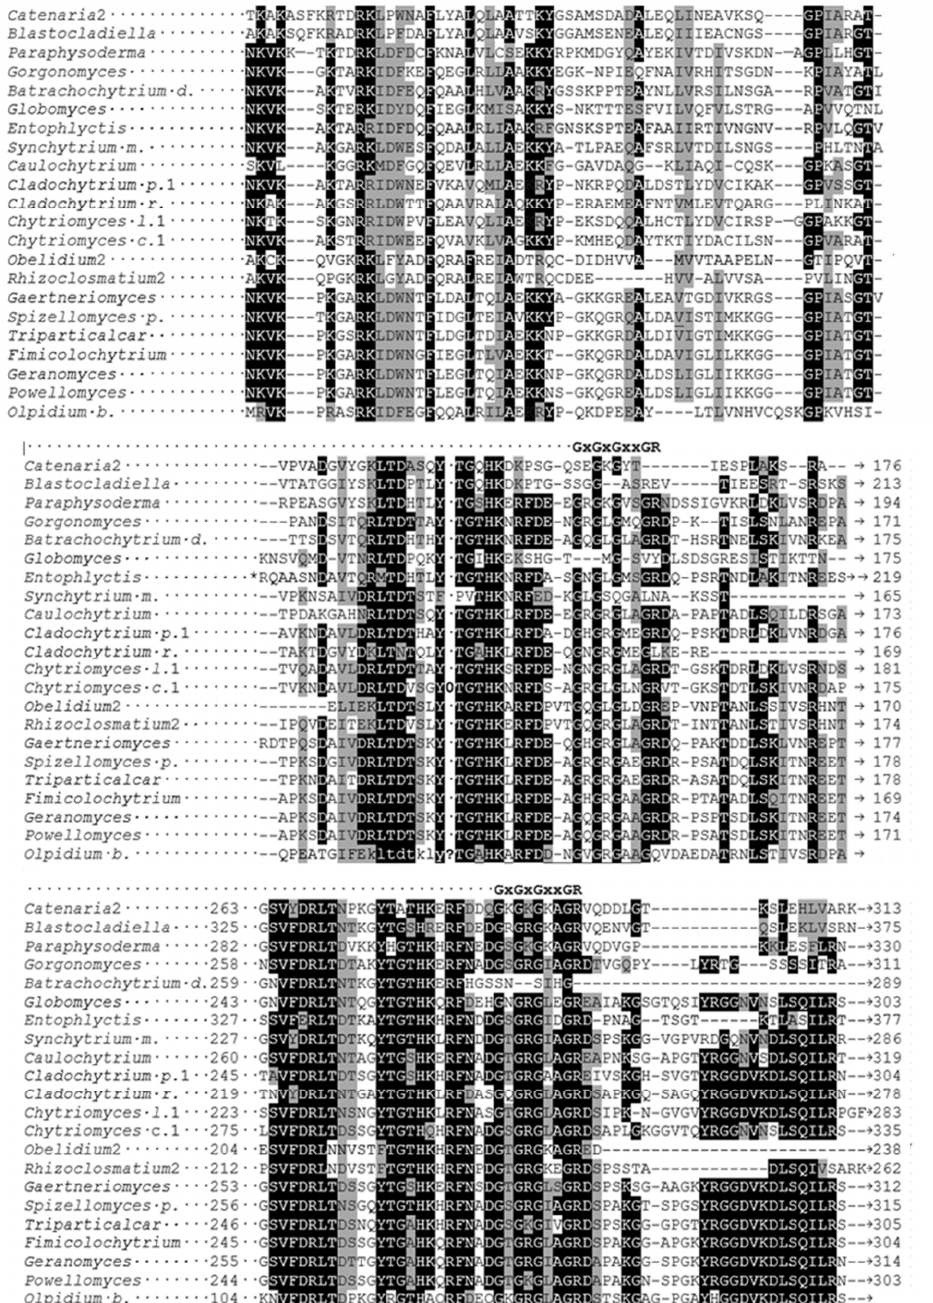
Figure 4. Multiple alignment (manually refined) of the p25alpha domains of fungal-type TPPPs by Clustal Omega [20]. The N-termini (amino acids before the p25alpha domain) and the interdomain parts are not included in the alignment. Amino acids that are identical and biochemically similar in at least two thirds of the proteins are labeled by black and grey background, respectively. The “Rossman-like” sequences, GXGXGXXGR, are also shown. The positions of a phase 1 intron of some proteins and that of a phase 0 intron of Chytriomyces confervae TPX65513 protein are marked by number 1 and 0, respectively. Asterisk (*) indicates that 39 amino acids of Enthel1467718 protein of Entophlyctis helioformis following the arginin (R) are not shown for clarity. Question marks (?) indicate the positions of the tentative introns of Olpidium bornovanus TPPP. The Accession Numbers of fungal proteins are listed in Table 1. The possible starting methionine may be encoded by triplets 1505–1507 or 1511–1513 (Figure 2). There are examples of an intron with such a position; in Rhizoclosmatium globosum ORY45507 and Obelidium mucronatum Obemuc1859513 fungal-type TPPPs; there are phase 1 introns here in both cases (Figure 4). Thus O. bornovanus TPPP is encoded probably by four exons. Based on the combination of the partly supplemented sequence of KAG5460860 and the sequence of KAG5458366, a more complete but still an incomplete hypothetical protein sequence can be produced, the very N-terminal part of which is still absent (Figure 3). Using this sequence as query in BLASTP search of the NCBI website, fungal-type TPPPs of various fungi were obtained as best hits (Table 2). Each of them